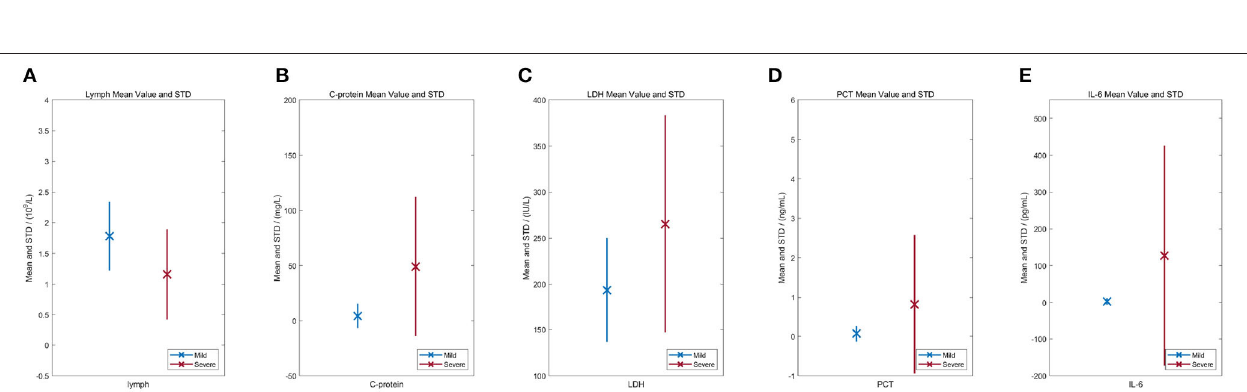
FIGURE 10 | Statistical characteristics of biomedical indices. stands for the mean value. The red and blue bar stands for the standard deviation for severe and mild × cases, respectively. (A) Lymphocyte (absolute value). (B) C-reactive protein. (C) Lactate dehydrogenase. (D) Procalcitonin. (E) Interleukin-6.